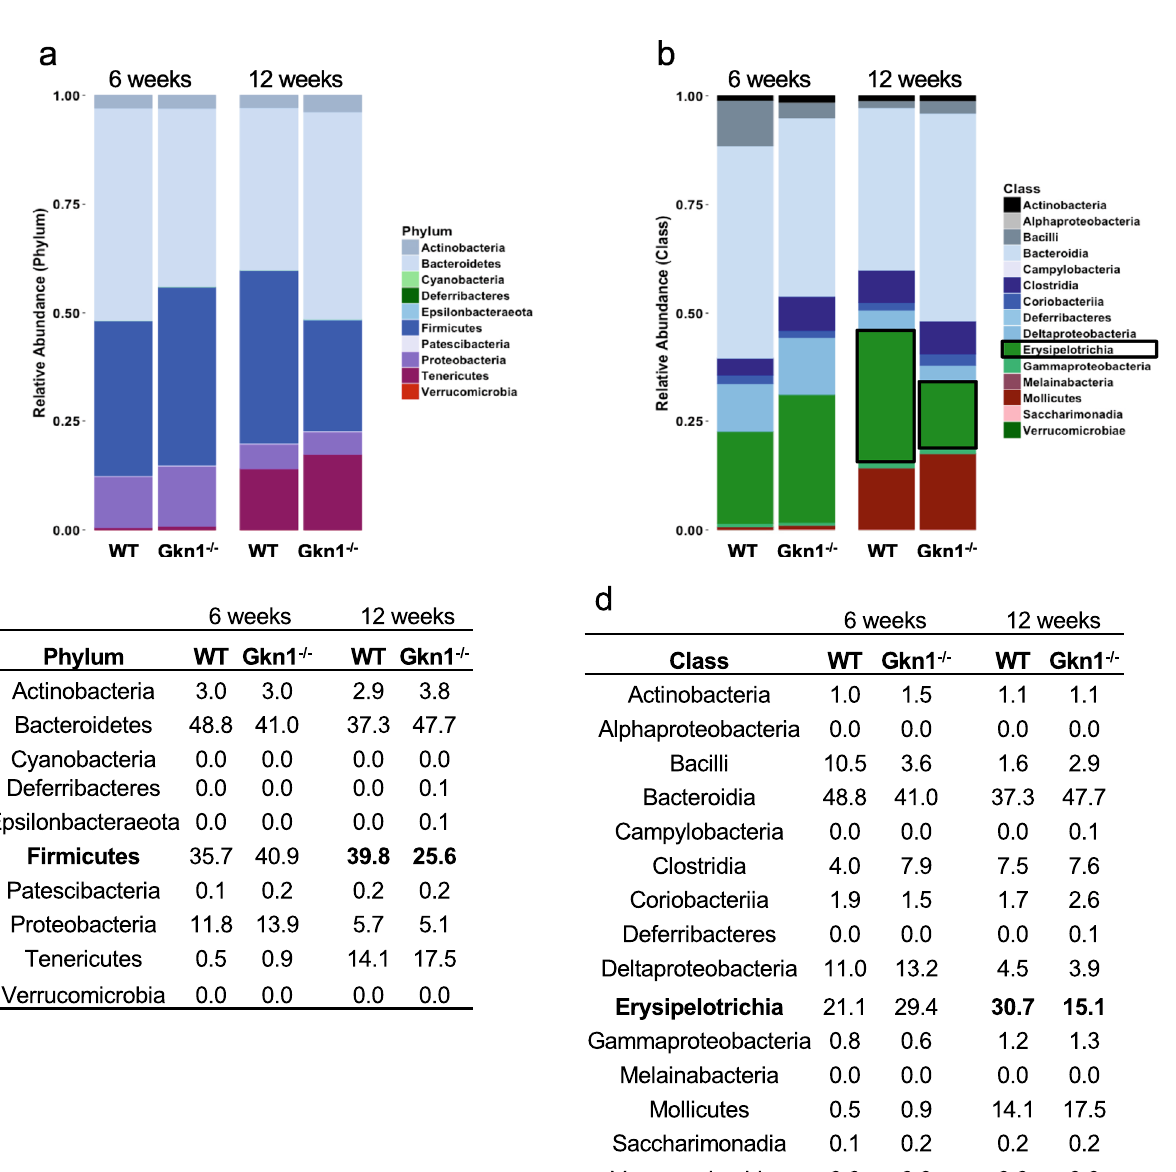
Figure 3. GKN1 regulates the small bowel microbiome. (A-D) Phylogenetic analysis of small bowel microbial populations in WT and GKN1 −/− mice at 6 and 12 weeks of age on NCD. ( a,c ) Relative phyla abundance in the small bowel of mice showing significantly reduced abundance of Firmicutes in 12-week, but not 6-week-old GKN1 −/− mice (bolded numbers are p < 0.01 n = 7). ( b , d ) Relative class abundance in the small bowel of mice showing decreased abundance of Erysipelotrichia in 12-week but not 6-week-old mice (bolded numbers are p < 0.01 n = were observed in female GKN1 −/− mice (Supplemental Figure S3). Thus GKN1 −/− mice are resistant to HFD-diet induced obesity and hepatic steatosis.